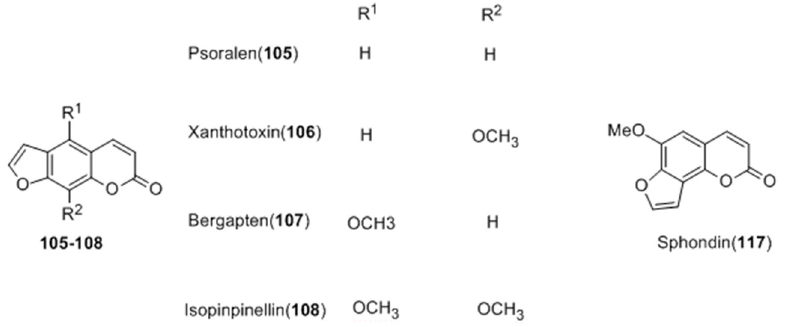
Figure 19. Structures of coumarins isolated from seven Umbelliferae crude drugs.